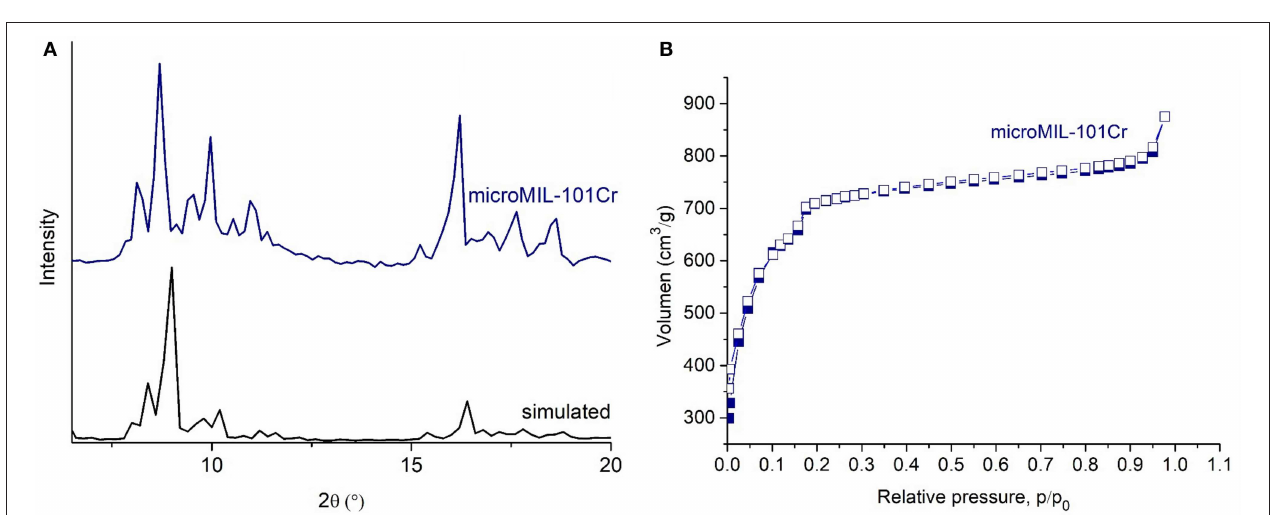
FIGURE 5 | PXRD patterns (navy blue for microMIL-101Cr (A) , black for simulated PXRD pattern from the cif-file of MIL-101Cr, CCDC number: 605510) (Férey et al., 2005). N 2 sorption isotherms of microMIL 101Cr (B) . Filled symbols depict adsorption, empty symbols